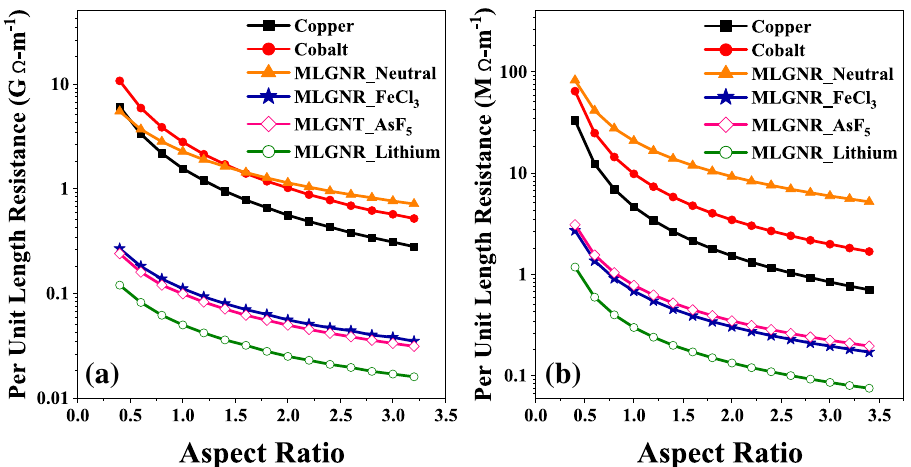
Figure 14. Per unit length electrical resistance for ( a ) intermediate level (L = 10 µ m) and ( b ) global level (L = 1 mm)